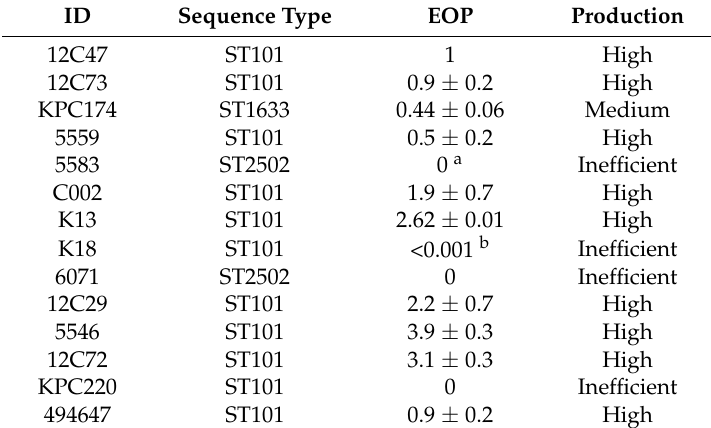
Table 2. Efficiency of plating (EOP) for phage vB_Kpn_F48 on K. pneumoniae isolates sensitive to the phage infection. For each isolate, the strain identifier, the sequence type and the EOP are reported. Each EOP value is the mean of three observations ± SD. EOP of the original strain of isolation is marked in bold and the type of phage production is ranked according to Viazis and colleagues [46]. ID Sequence